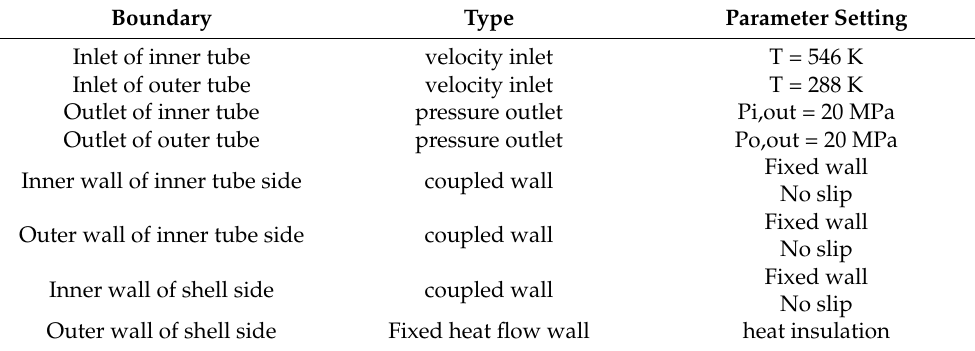
Table 4. Boundary conditions.